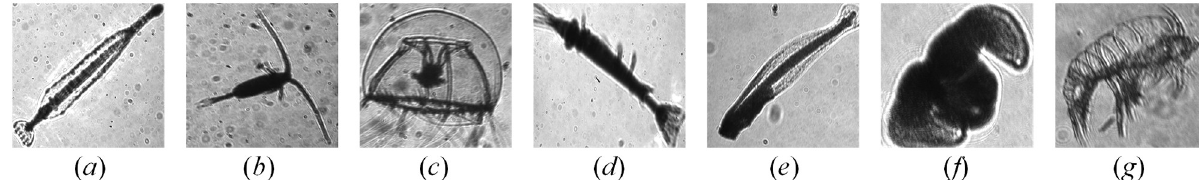
Fig 1. Example images of 7 classes in our in situ plankton dataset. ( a ) chaetognatha; ( b )copepoda; ( c ) medusae; ( d ) euphausiids; ( e ) fish larvae; ( f ) Limacina; ( g ) other zooplankton or objects.